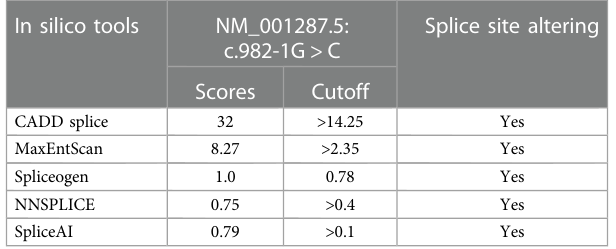
TABLE 1 Splicing prediction of the novel variant c.982-1G>C in CLCN7